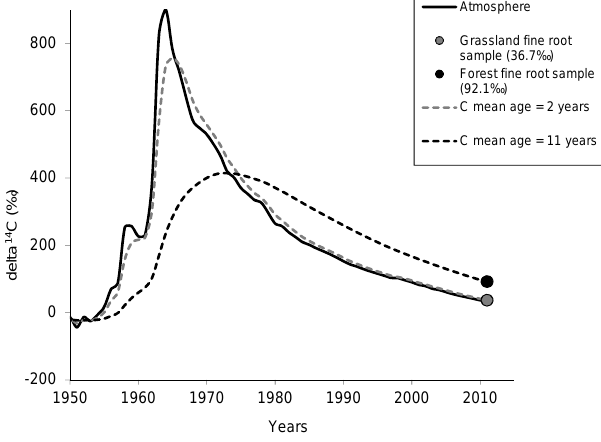
Fig. 1. Example of the model we used to determine the mean age of fine root C from the 14 C signature of the fine roots (Gaudinski et al.,